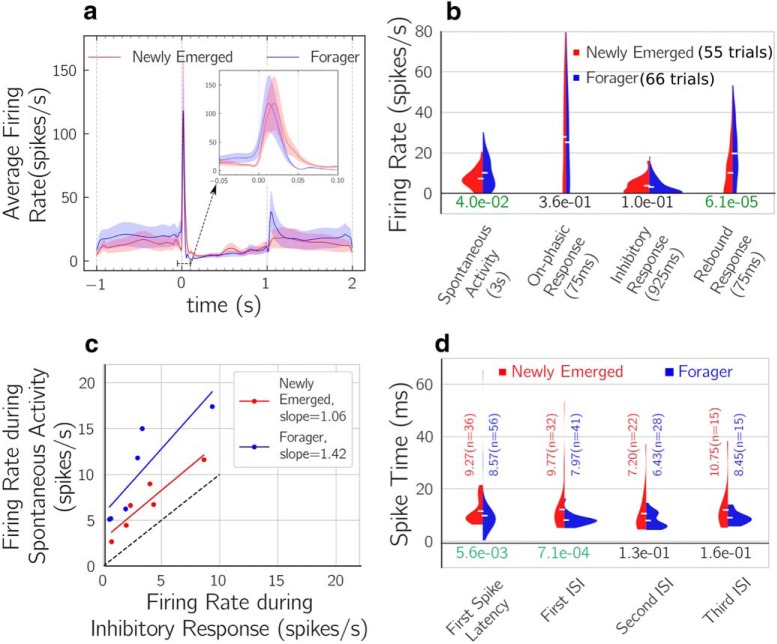
Analysis of electrophysiological properties. a, Comparison of the average firing rate profiles of newly emerged adult and forager DL-Int-1 neurons. Smoothed estimates of time-resolved average firing rates were calculated from responses aligned to stimulus onset using adaptive kernel density estimation (Shimazaki and Shinomoto, 2010). Solid lines indicate average firing rates, whereas shaded regions indicate 95% confidence intervals. Inset, Average firing rate during on-phasic response with expanded time scale. b, Comparison of firing rates during four activity periods. The filled areas represent firing rate distributions estimated using kernel density estimation (see Methods, Analysis of electrophysiology). The distributions were normalized to have equal areas. Horizontal white markers indicate mean values of the distributions. The numbers below the distributions are p values calculated using Mann–Whitney U test. P-values <5% are highlighted in green. Firing rates during spontaneous activity and rebound response showed significant increases. c, Comparison of the strength of inhibition relative to spontaneous activity by plotting the firing rates during the two periods against each other. Lines were fit using linear least-squares regression. The dashed line indicates the line of slope 1. d, Comparison of the timing of the first four spikes of the response using first spike latency, first ISI, second ISI, and third ISI. The distributions were estimated using Kernel Density estimation and normalized to have the same area. The numbers under the distributions are p values calculated using Mann–Whitney U test. Horizontal white markers indicate mean values, which are also shown above the distributions with sample numbers in parentheses. Spiking response was faster in foragers compared with newly emerged adults with significant reductions in first spike latency and first ISI.